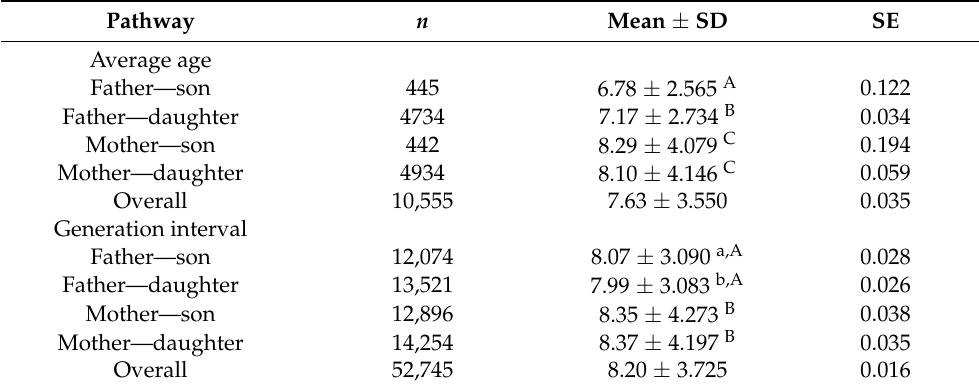
Table 2. Average age of parents at the birth of their offspring and generation interval (years) for the Croatian Posavina horse (REF 01).